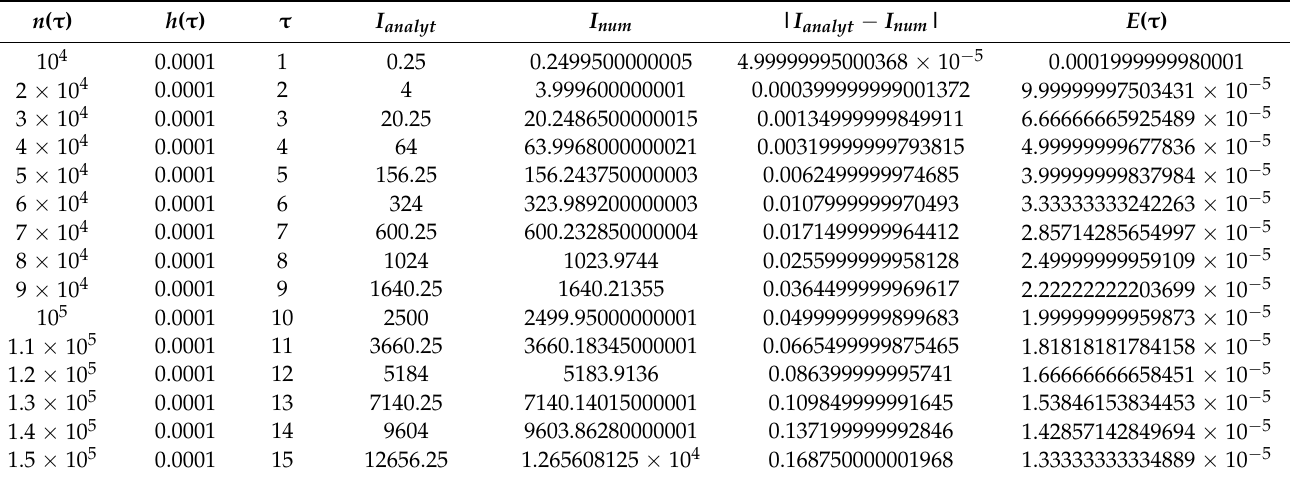
Table 13. Calculation of integral